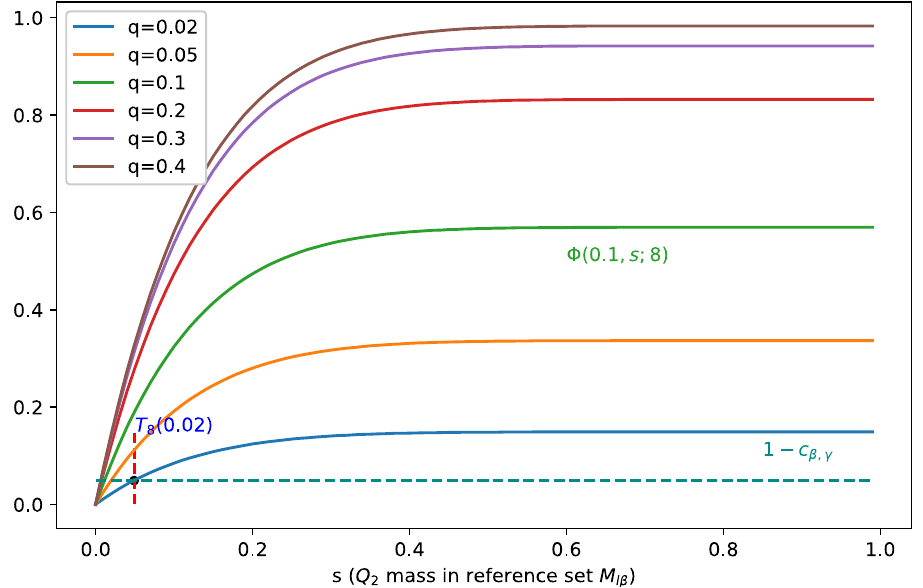
M covers more mass of l  Q that M should 1 l 